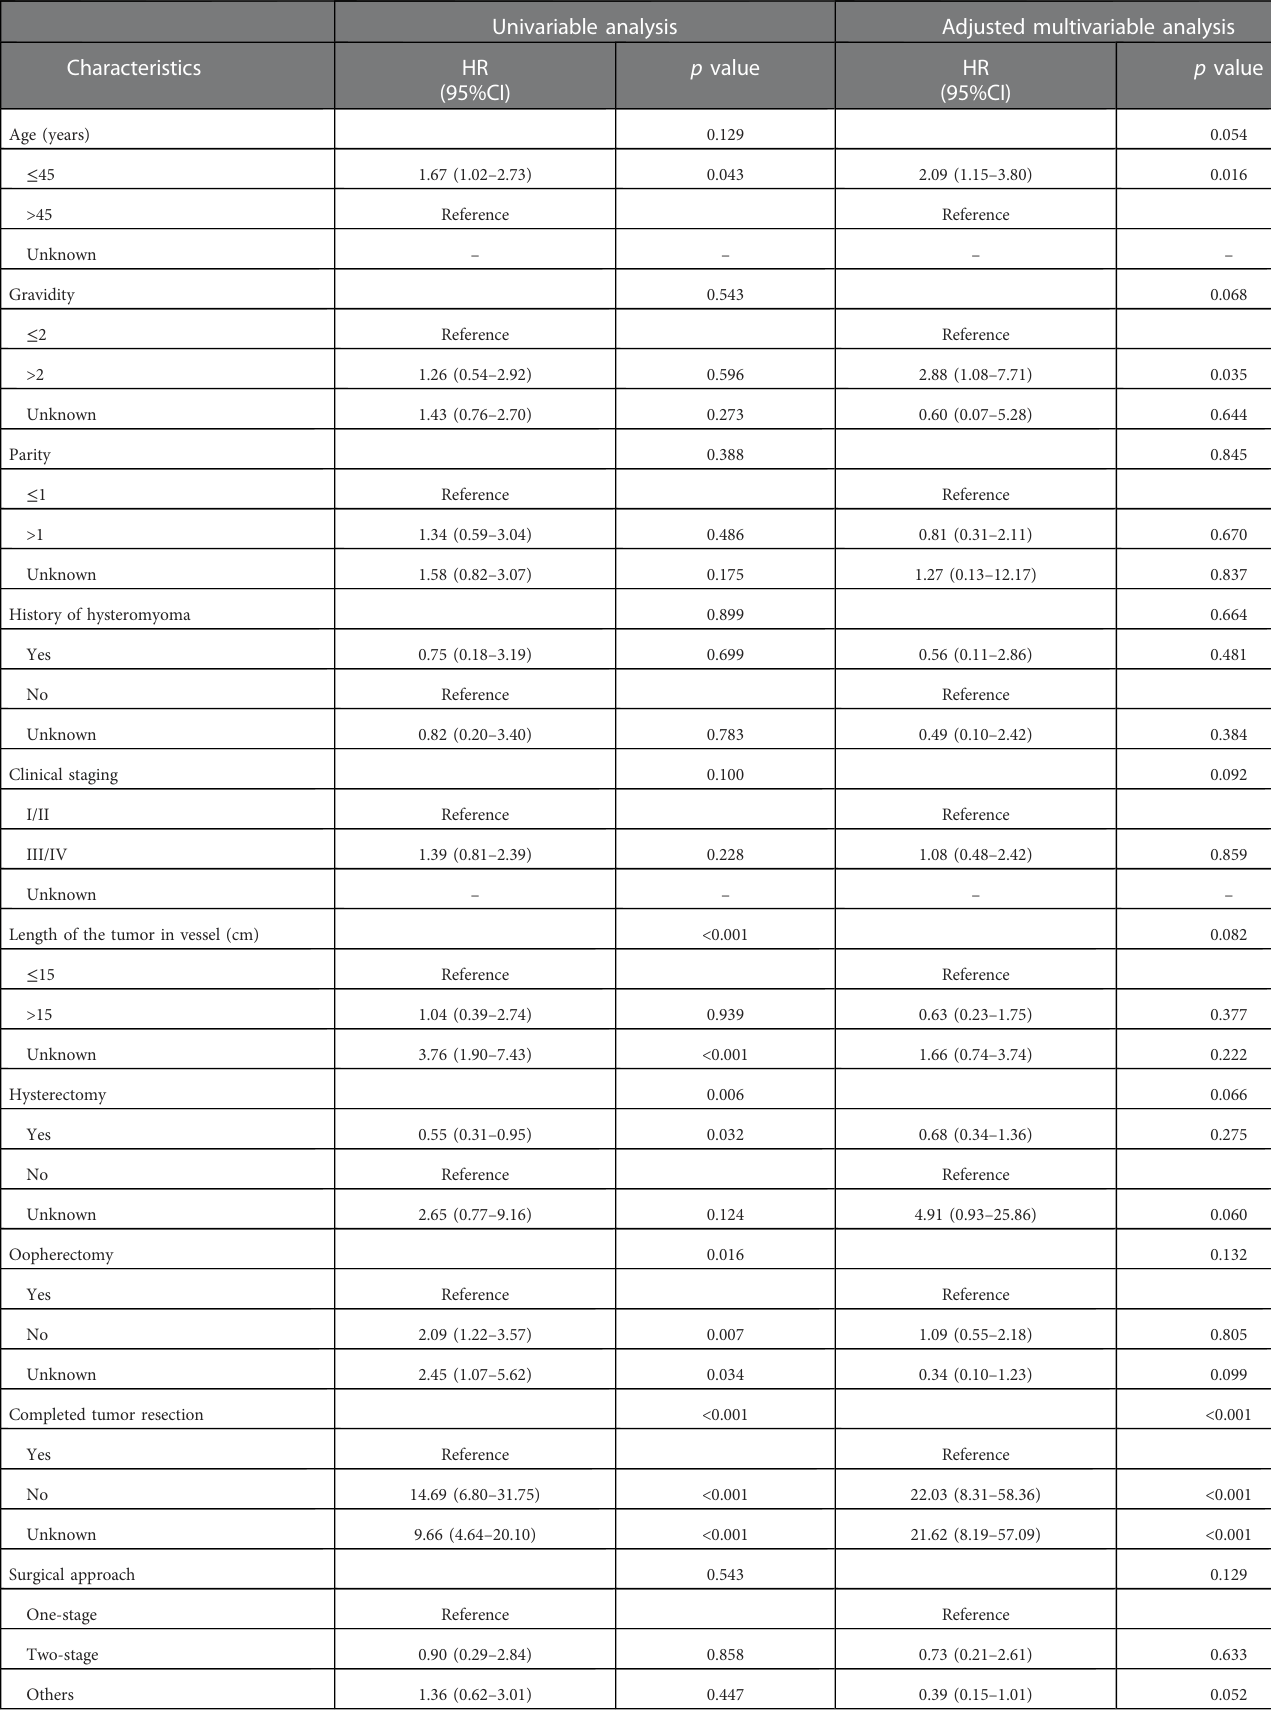
TABLE 3 Univariable and adjusted multivariable Cox proportional hazards regression analysis for PFS of 361 IVL